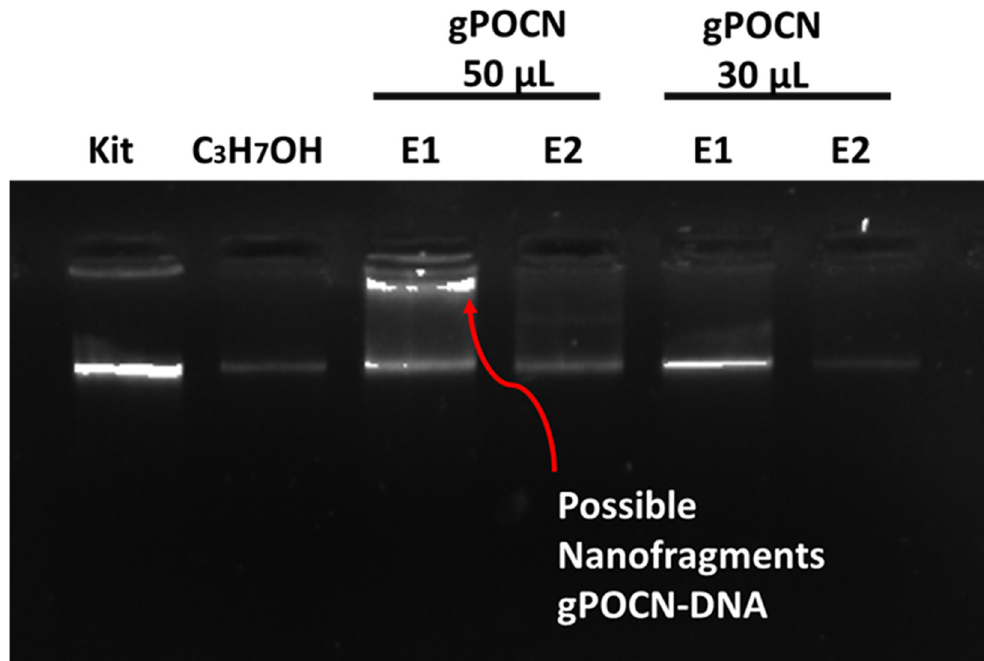
Figure 8. DNA extraction analyzed by electrophoresis onto a 1% agarose gel. Lane 1, extraction with the commercial Qiagen Kit; lane 2, extraction with the isopropanol method; lane 3, extraction with g-POCN (50 µL) first elution; lane 4, extraction with g-POCN- 50 (µL) second elution; lane 5, extraction with g-POCN (30 µL) first elution; lane 6 extraction with g-POCN (30 µL) second elution.